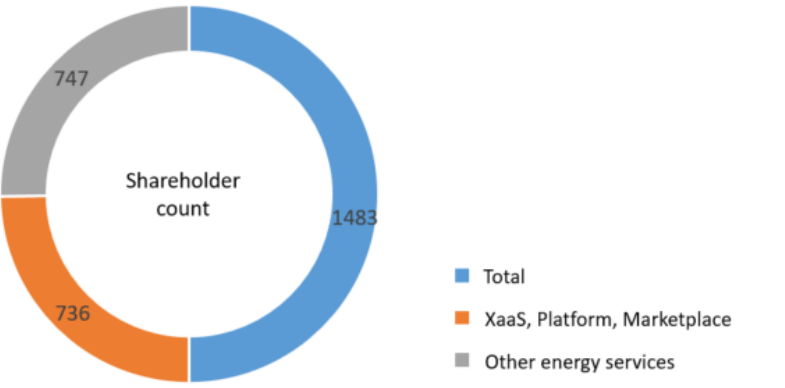
Figure 8. Shareholders count supporting platform, XaaS, marketplace and other energy services.